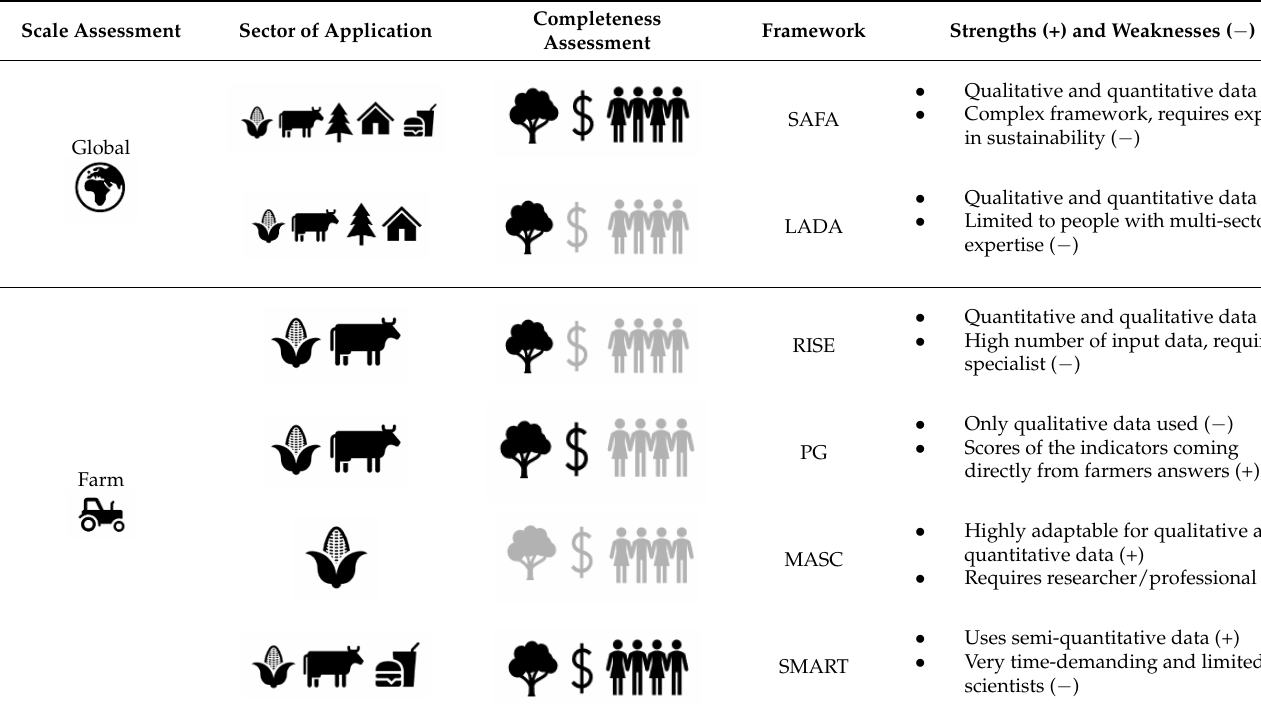
Figure 1. Total number of environmental, sociocultural and economic indicators used in each framework under study: RISE, MASC, LADA, SMART, SAFA and PG. Table 6. Decision tree according to the framework scale assessment (global/local), sector of ap- plication (cropping system, livestock system, forestry system, urban system and food sector) and completeness of sustainability assessment (environmental, economic and sociocultural dimensions). Icons in black represent a higher number of themes whereas grey represent a lower number of themes in each dimension. Strengths and weaknesses related to the user-friendliness of the tool and the use of qualitative/quantitative data are also